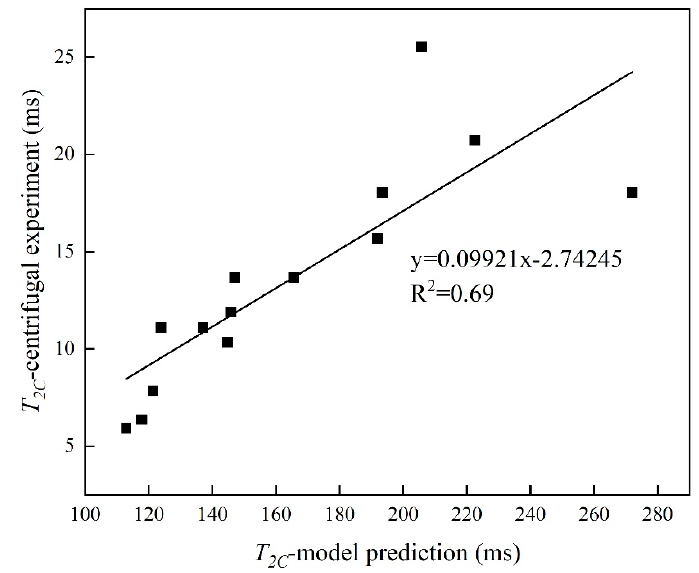
Figure 16. Cross-plot of the model’s prediction of T 2C and centrifugal experiment’s T 2C.